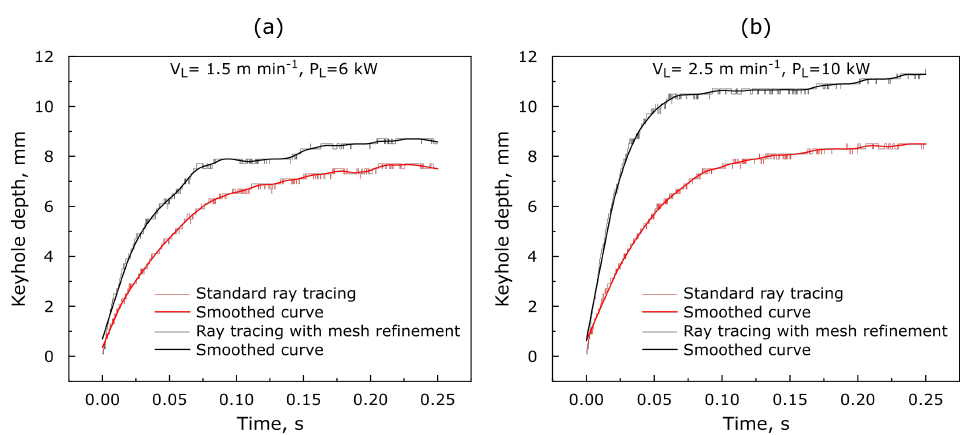
Figure 7. Comparison of the calculated drilling curves with the standard and virtually refined ray tracing algorithms: ( a ) V L = 1.5mmin − 1 , P L = 6kW, ( b ) V L = 2.5mmin − 1 , P L =